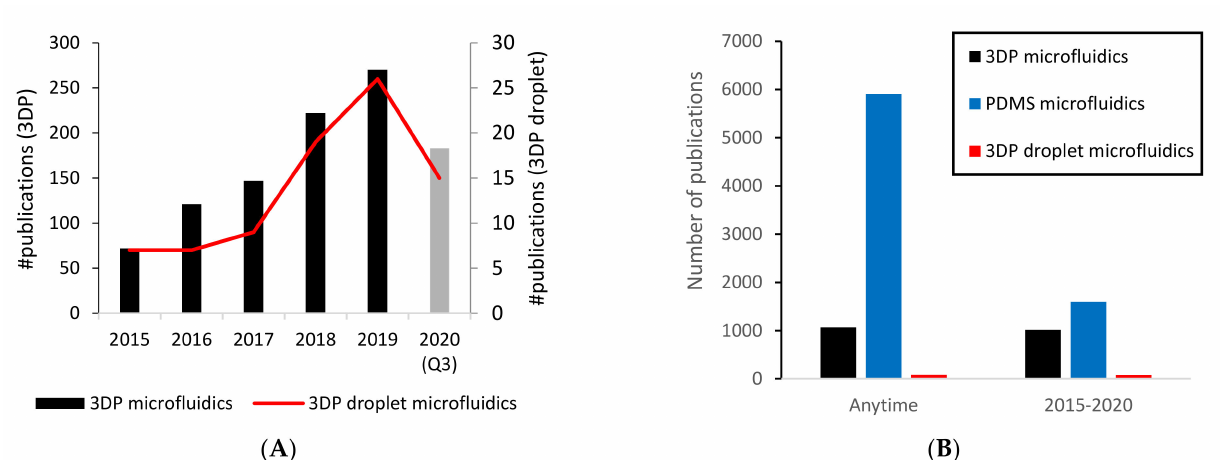
Figure 1. The number of scientific papers about 3D-printed (3DP) microfluidics has increased nearly fourfold over the last five years. Based on the number of publications reported by Web of Science, ( A ) interest toward 3DP microfluidics has steadily risen during the last five years. Droplet microfluidics is a fairly new application area for 3DP microfluidics that has rapidly risen in popularity since 2015. Furthermore, ( B ) while polydimethylsiloxane (PDMS) is still the primary choice of material for microfluidic chips, new publications have been in a rapid decline. In comparison, most 3DP microfluidics papers have been published since 2015. Search parameters and results are listed in Table S1 in supplementary material